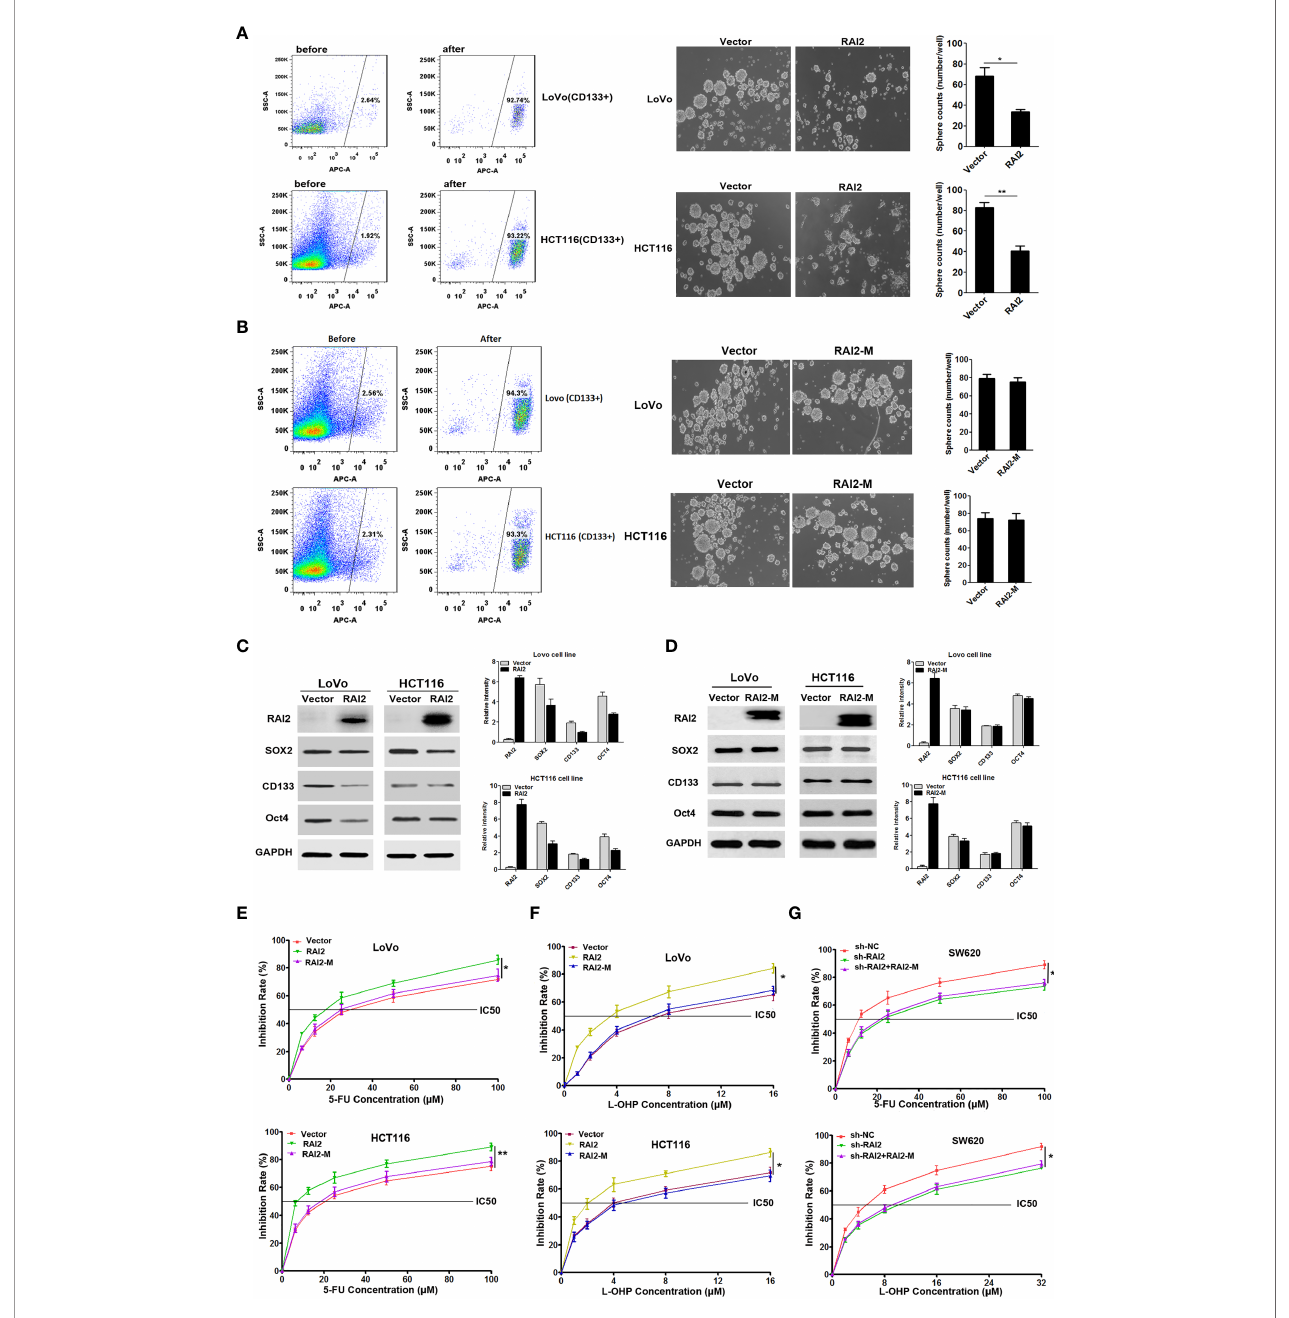
FIGURE 5 | RAI2 inhibited CRC stem cell-like properties and increased the chemosensitivity of CRC cells to 5-FU and L-OHP. (A) Left panel: Representative images showing CD133-positive cell proportion before and after fl uorescence-activating cell sorting by CD133 antibody in LoVo/HCT116 cells. Right panel: Representative images showing sphere-forming ability affected by RAI2 re-expression in LoVo/HCT116 cells. (B) Left panel: Representative images showing CD133-positive cell proportion before and after fl uorescence-activating cell sorting by CD133 antibody in LoVo/HCT116 cells. Right panel: Representative images showing sphere-forming ability affected by RAI2-M re-expression in LoVo/HCT116 cells. (C) Western blot of CD133, SOX2 and OCT4 expression in RAI2 re-expressed or vector control cells. (D) Western blot of CD133, SOX2 and OCT4 expression in RAI2-M re-expressed or vector control cells. (E) Representative curves of growth inhibitory effects of 5-FU in LoVo/HCT116 cells with or without re-expression of RAI2/RAI2-M in different concentrations (0.00, 6.25, 12.50, 25.00, 50.00, 100.00 m M). (F) Representative curves of growth inhibitory effects of L-OHP in LoVo/HCT116 cells with or without re-expression of RAI2/RAI2M in different concentrations (0.00, 1.00, 2.00, 4.00, 8.00, 16.00 m M). (G) Growth inhibitory effect of 5-FU/L-OHP in SW620 cells with or without RAI2 knocked down and SW620 cells with both shRAI2 and RAI2-M transfected. The treatment concentrations of 5-FU in SW620 cells were (0.00, 6.25, 12.50, 25.00, 50.00, 100.00 m M), and the treatment concentrations of L-OHP were (0.00, 2.00, 4.00, 8.00, 16.00, 32.00 m M). The viability of cells was measured by MTT assay after 5-FU/L-OHP treatment for 48 hrs. p-values: * ≤ 0.05;